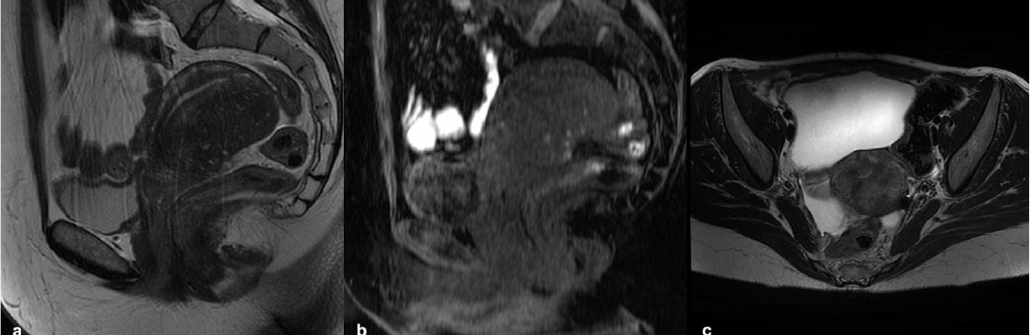
Figure 4. Posterior external adenomyosis: ( a ) sagittal T2-weighed image showing an hypointense ill-defined subserosa mass in the posterior myometrium and high-intensity cystic components within it. ( b ) Sagittal and axial T1-weighted image showing high-signal-intensity spots which correspond to some of the small high-signal-intensity areas seen on the T2-weighted image. This hyperintense foci on T1W represent hemorrhage within the ectopic endometrial tissue. ( c ) Axial T2-weighted image showing posterior external adenomyosis with deep endometriosis of the posterior compartment (involvement of the serous and muscular layers of the superior rectum showing hypointense thickening).